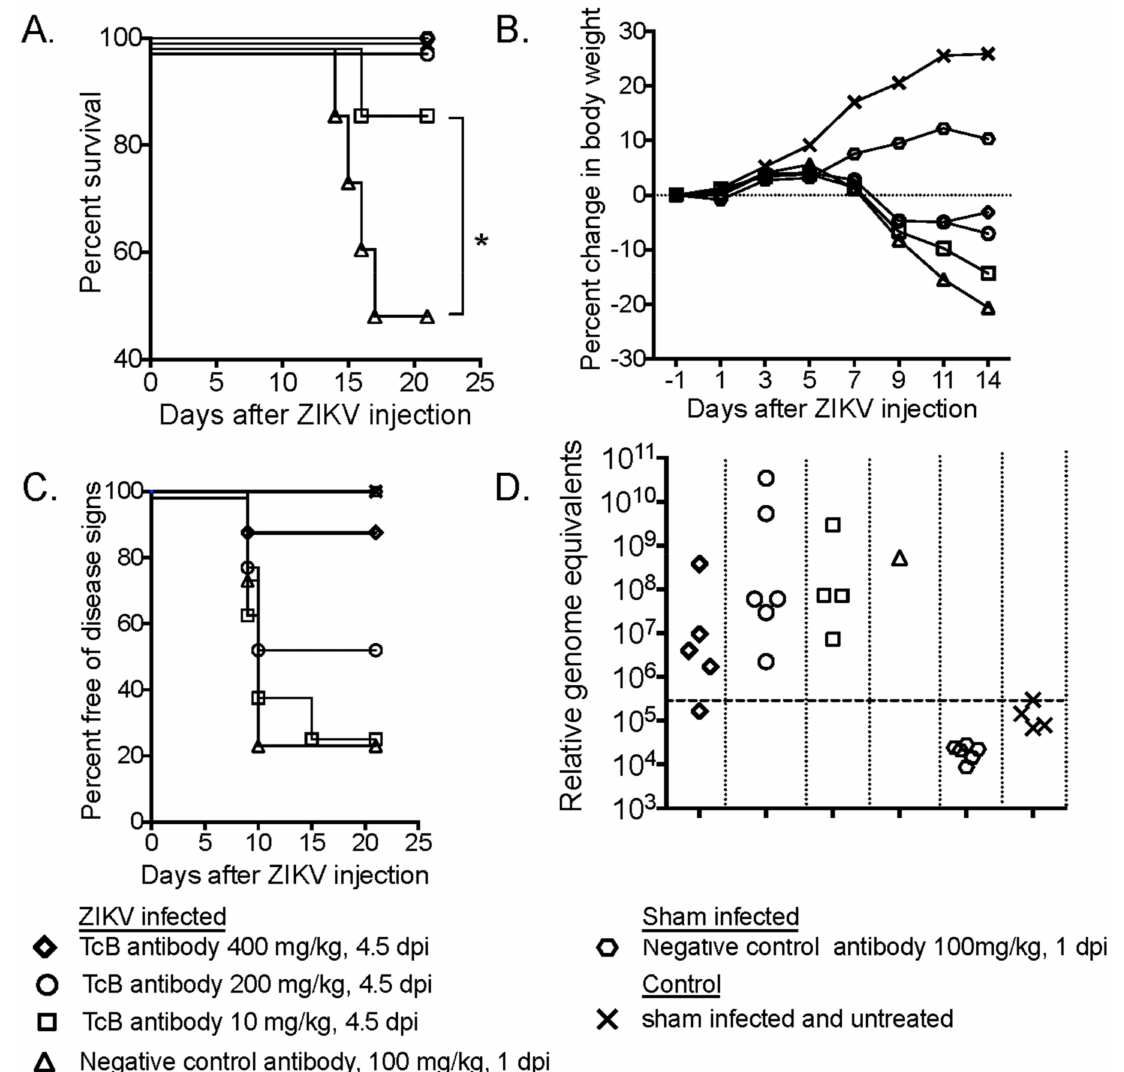
Figure 4. Identifying effective dose of SAB-155 treatment. Most of the groups had equal numbers of male ( n = 4) and female ( n = 4) STAT2 KO hamsters s.c. infected with PRVABC69 and treated with different doses of SAB-155 at 4.5 dpi and negative control antibody at 1 dpi by i.p. administration. Groups treated with SAB-155 of 200 and 400 mg/kg had 6 male and 2 female hamsters. Sham infected controls had 3 each from both sexes. ( A ) Percent survival, (since three groups had 100% survival, Y axis was adjusted to display all groups); ( B ) percent change in body weight relative to the day of virus challenge; ( C ) percent free of conjunctivitis; ( D ) RT-PCR analysis of ZIKV RNA in testis at 21 dpi. *, p < 0.05 survival curve analysis ( A ). P -values obtained by comparing negative control antibody 100 mg/kg with 10 mg/kg of SAB-155 treated at 1 dpi. Dashed lines represent limit of detection in Figure